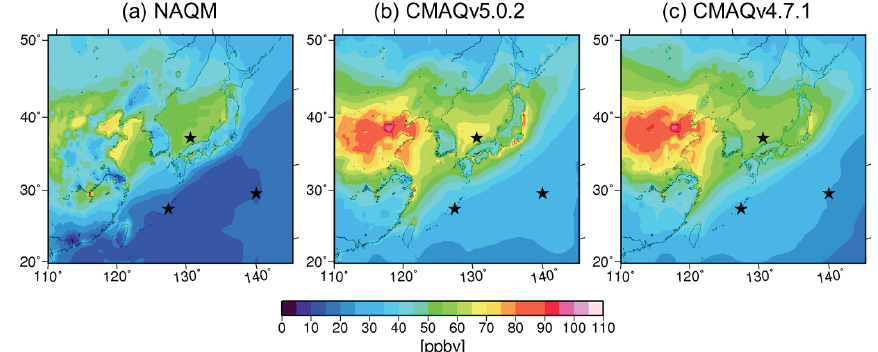
Figure 7. Comparison of the spatial distribution of surface O 3 mixing ratios in East Asia in July simulated by (a) NAQM, (b) CMAQ 5.0.2, and (c) 4.7.1.